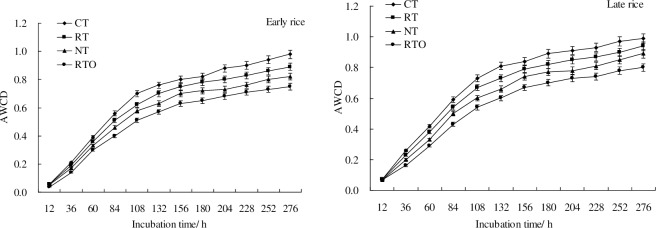
AWCD changes with incubation progress with different tillage treatments at early rice and later rice maturity stages.* Abbreviations: CT: conventional tillage with residue incorporation; RT: rotary tillage with residue incorporation; NT: no-tillage with residue retention; RTO: rotary tillage with residue removed. Vertical bars represent the standard error (n = 3). The same as below.